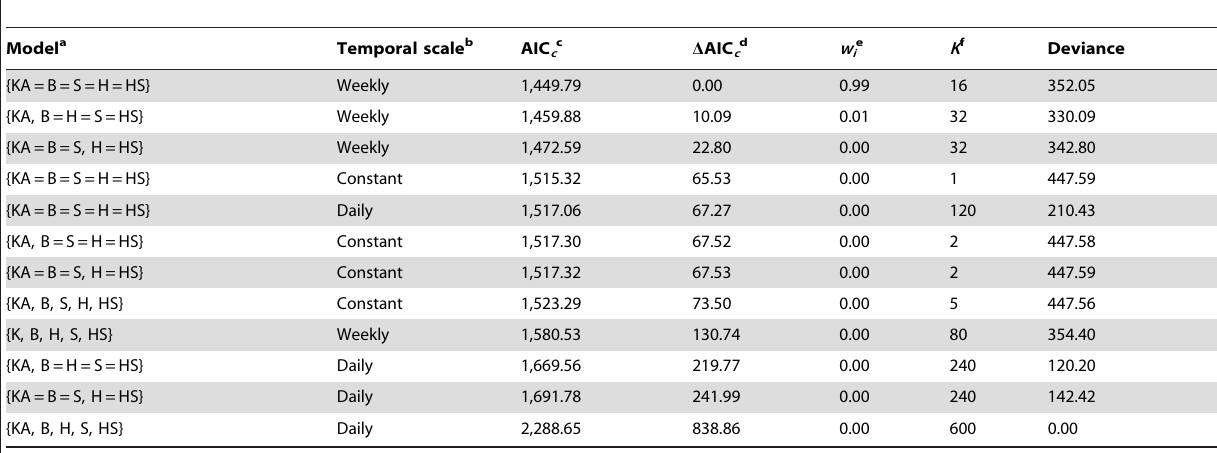
Table 5. Survival models using Program MARK for white-tailed deer from birth to 120 days using known-age newborn fawns and ages estimated from published neonatal-age models based on new-hoof growth, South Dakota and Minnesota, USA, 2001–2009.